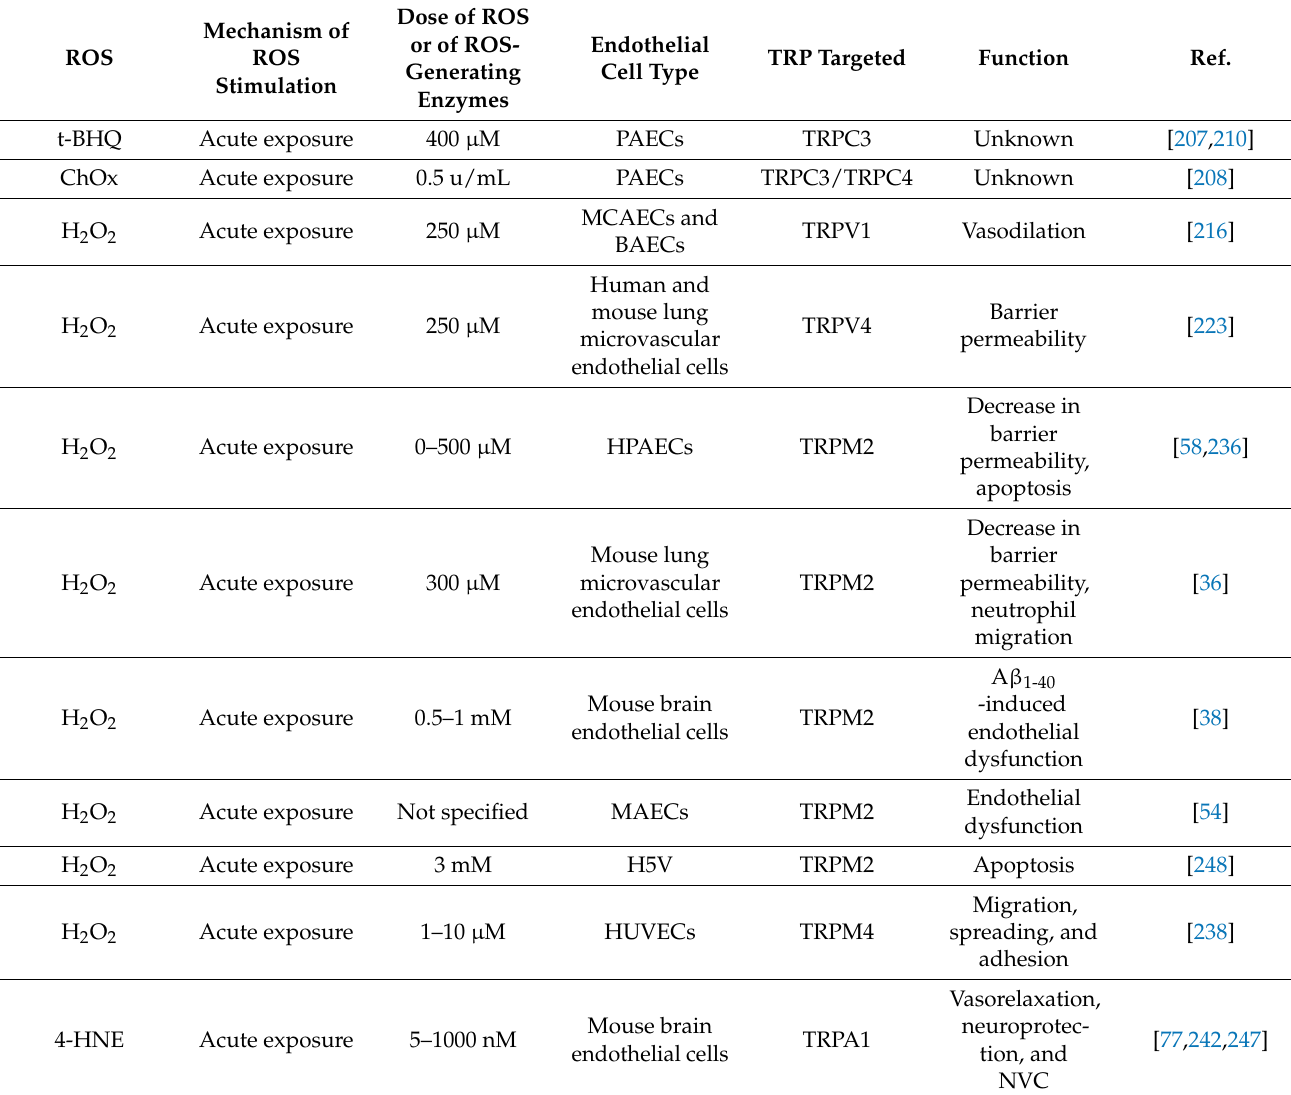
Table 2. Representative studies showing the direct effect of ROS on endothelial TRP